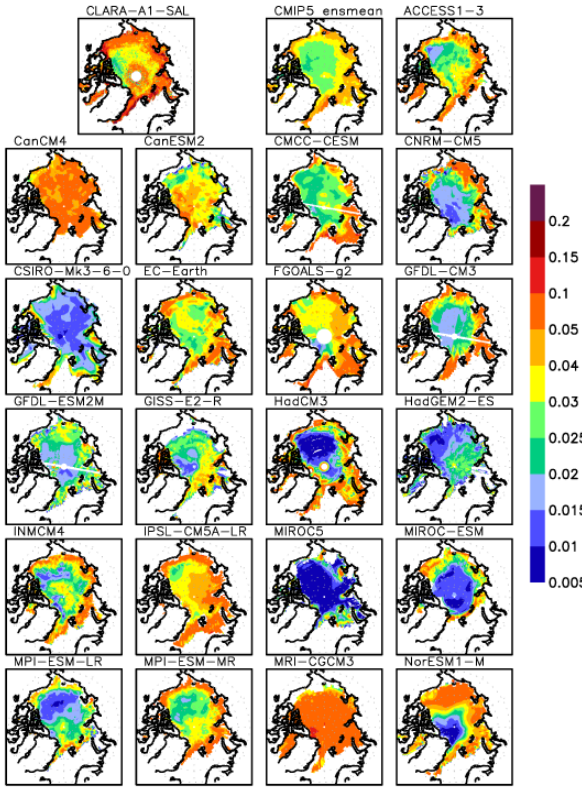
Fig. 6. Standard deviation of summer-averaged (JJA) sea ice albedo in CLARA-SAL, the CMIP5 ensemble mean and the individual CMIP5 models. Shown is the time average over